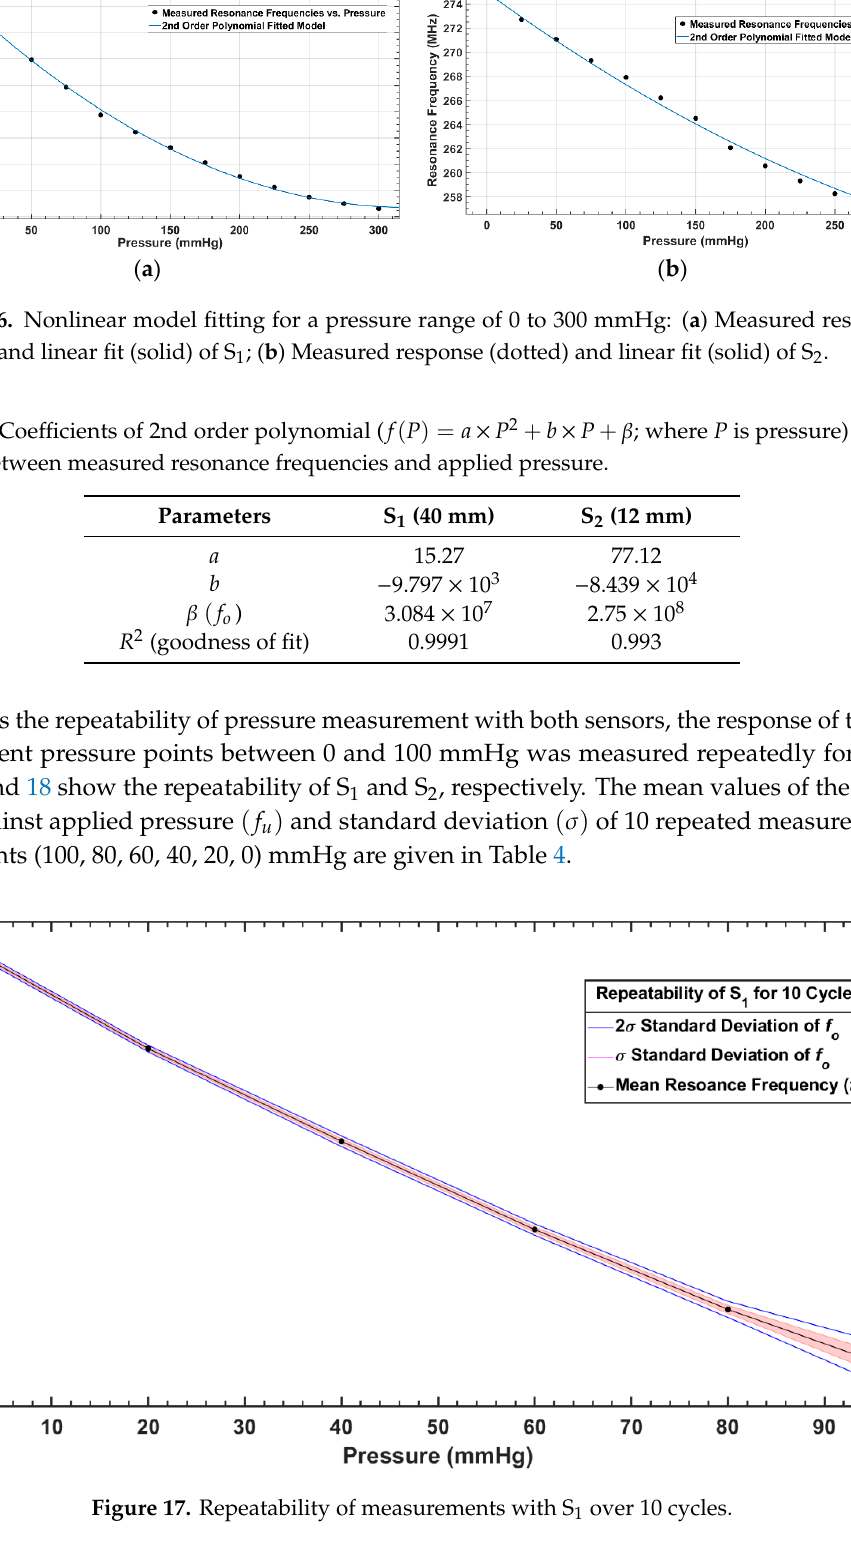
Figure 17. Repeatability of measurements with S 1 over 10 cycles.